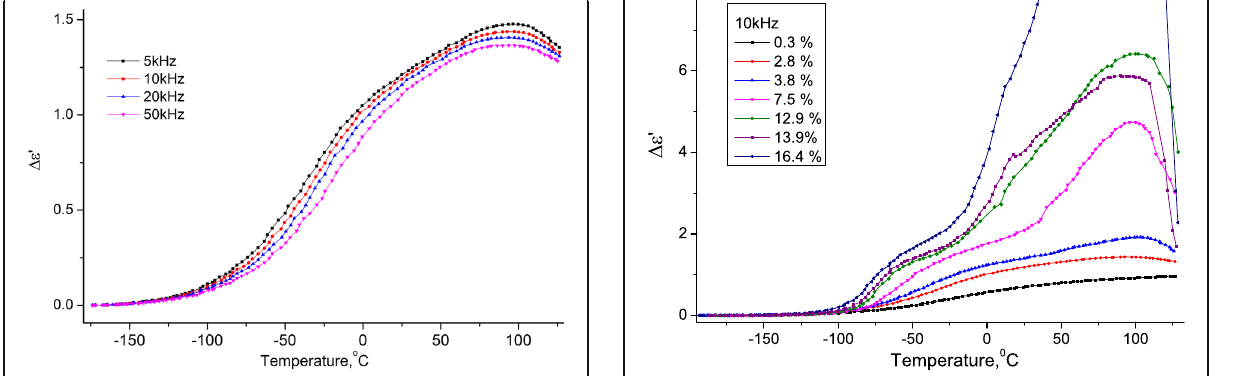
Fig. 12 Temperature dependence of the change of increment of the real part of the dielectric permittivity of MCC. Temperature (cid:6) (cid:6) dependence of the change of increment of the real part ) (cid:6) T ¼ − 180 o C (cid:6) ) of the dielectric ( Δ ε ′ = ε ′ ( T ) − ε ∞ , where ε ∞ ¼ ε ′ T ¼ − 180 o C permittivity of MCC samples with different water